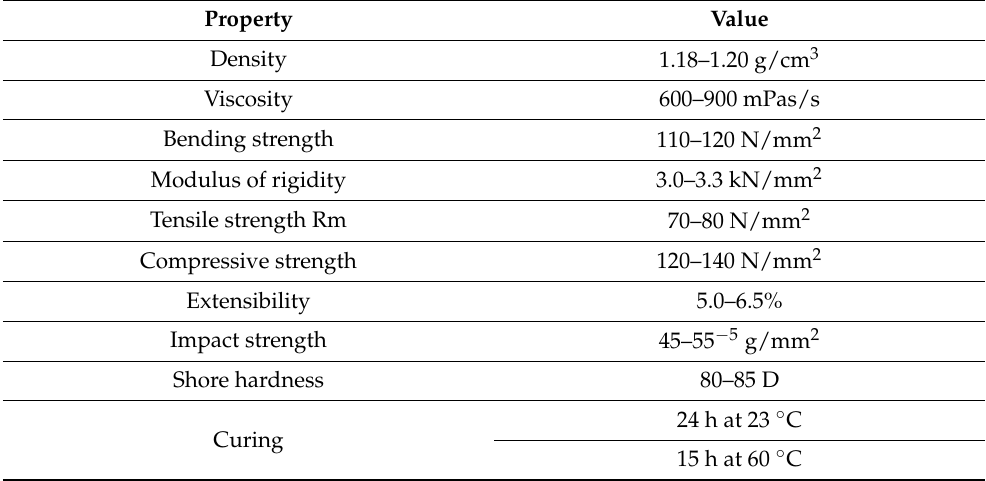
Table 1. L 285 MGS resin parameters.